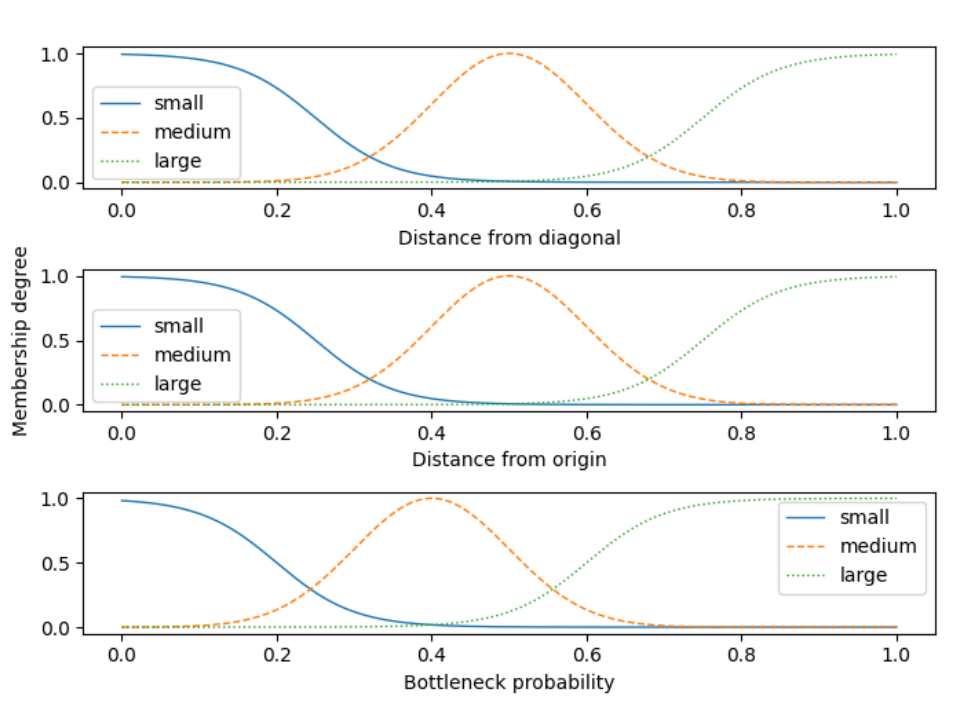
Figure 5. Initial FIS setup for the bottleneck probability